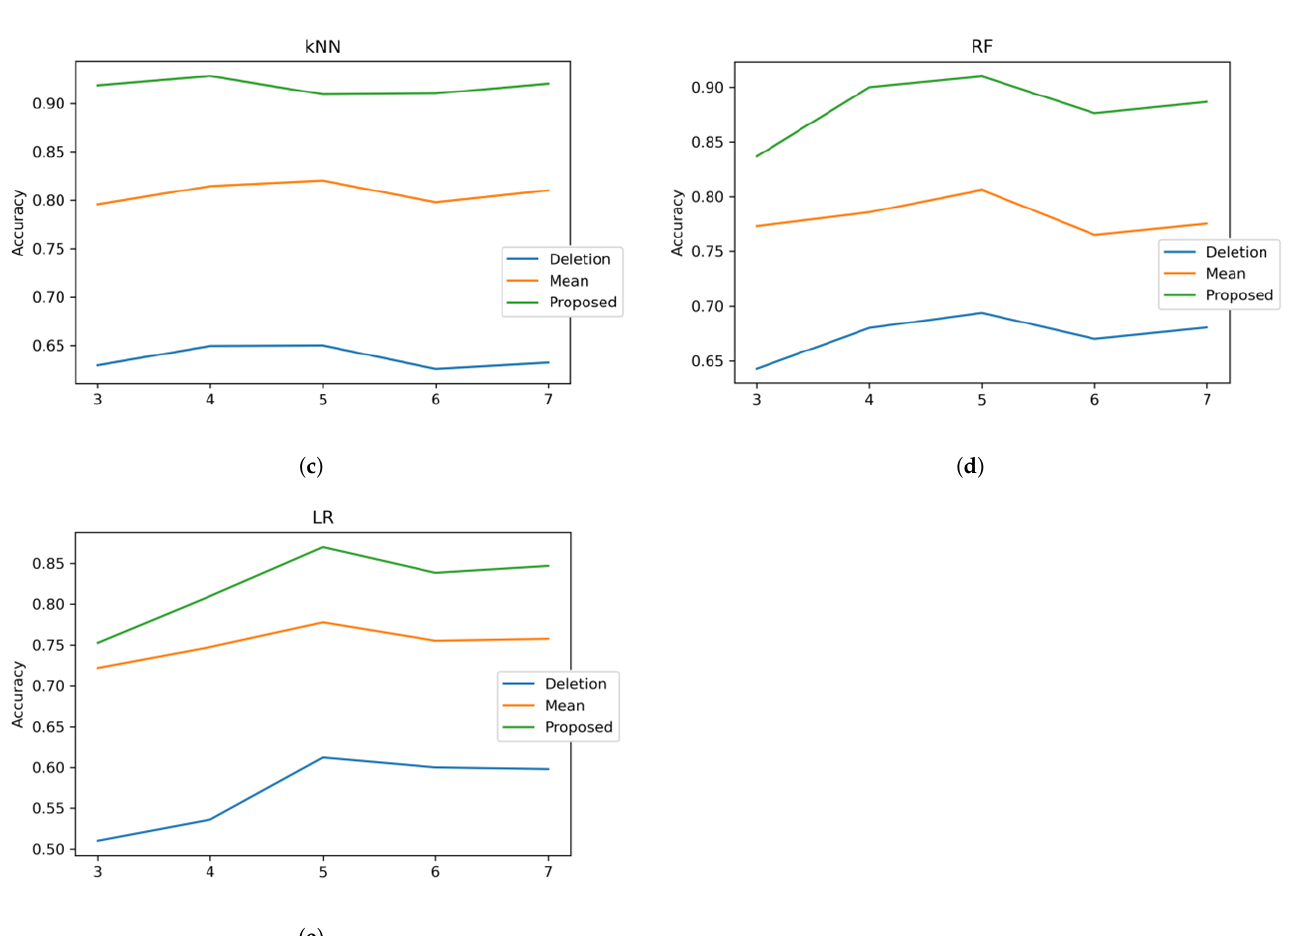
Figure 5. Accuracy comparison of LR when a different number of features are considered: ( a ) SVM, ( b ) NB, ( c ) kNN, ( d ) RF and ( e )